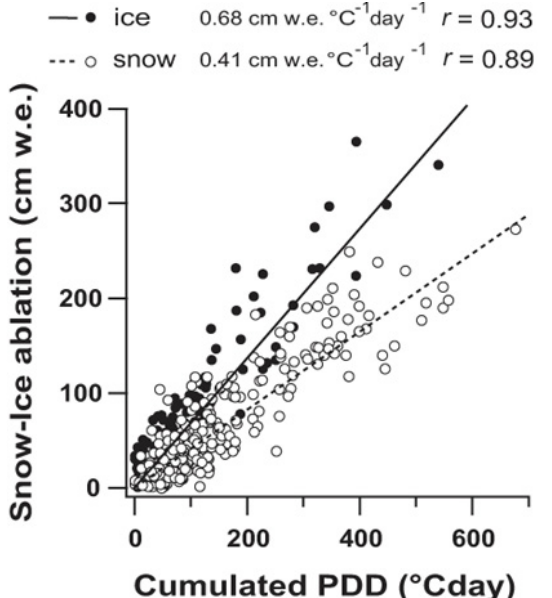
Fig. 10. Measured ablation at stake 4 for snow and ice as a function of the cumulated positive degree day calculated from Lyon with a vertical lapse rate of 6.25 ◦ Ckm − 1 .